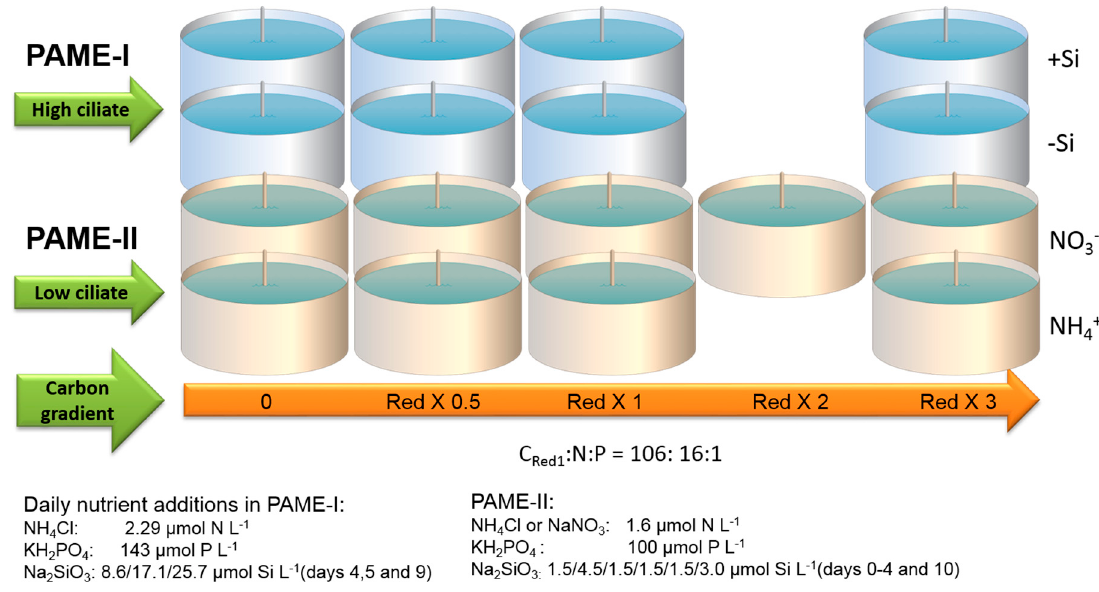
Figure 2. Experimental design of the two mesocosms, (Polar Aquatic Microbial Ecology) PAME-I (2007) and PAME-II (2008). Both experiments received the same dose of nitrogen (N) and phosphorus (P) in Redfield ratio (C:N:P = 106:16:1 molar). Glucose was added in two four-point carbon addition-gradients (0, 0.5, 1, 3 × Redfield in glucose) in PAME–I and one of the series in PAME-II. The other series in PAME-II was a five-point carbon addition-gradient (0, 0.5, 1, 2, 3 × Redfield in glucose C). Samples for this study were taken from the treatments with 0 and 3 × Redfield carbon additions. In PAME-I, nitrogen was added as NH 4 Cl. In PAME-II, nitrogen was added as NaNO 3 in the NO 3 − gradient and as NH 4 Cl in the NH 4+ gradient. In PAME-I, silicate was added to the +Si units only. In PAME–II all tanks were kept silicate-replete. More information about the